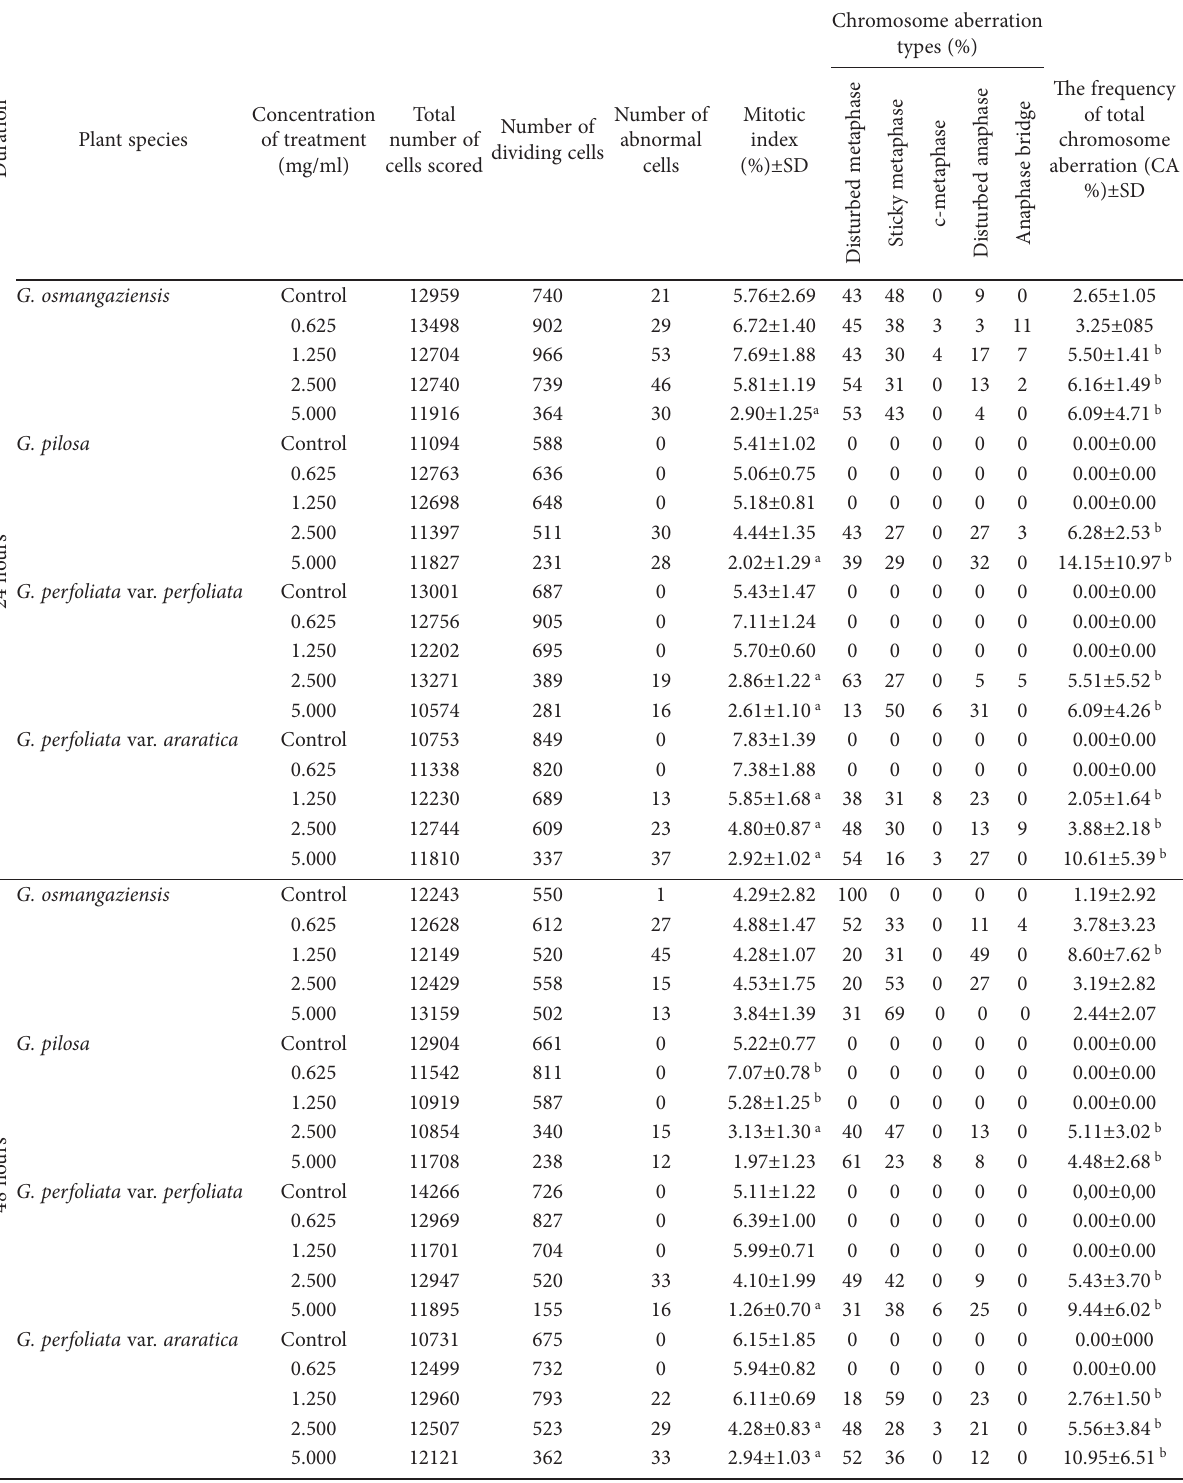
Table 1. Mitotic index and chromosome aberration types and their frequency induced by Gypsophila extracts in root tip cells of Allium